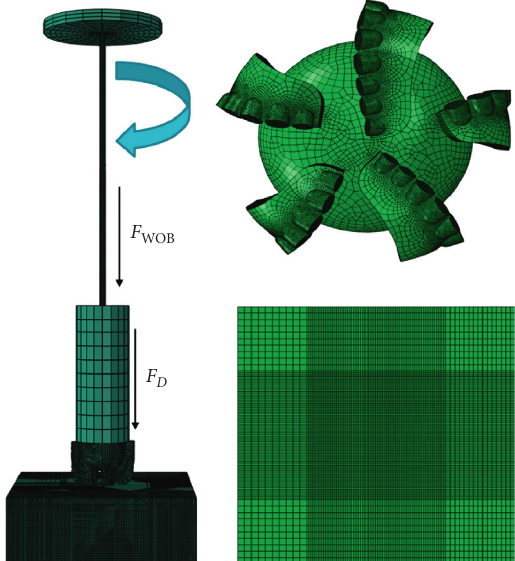
Figure 8: The finite element model of drilling process.